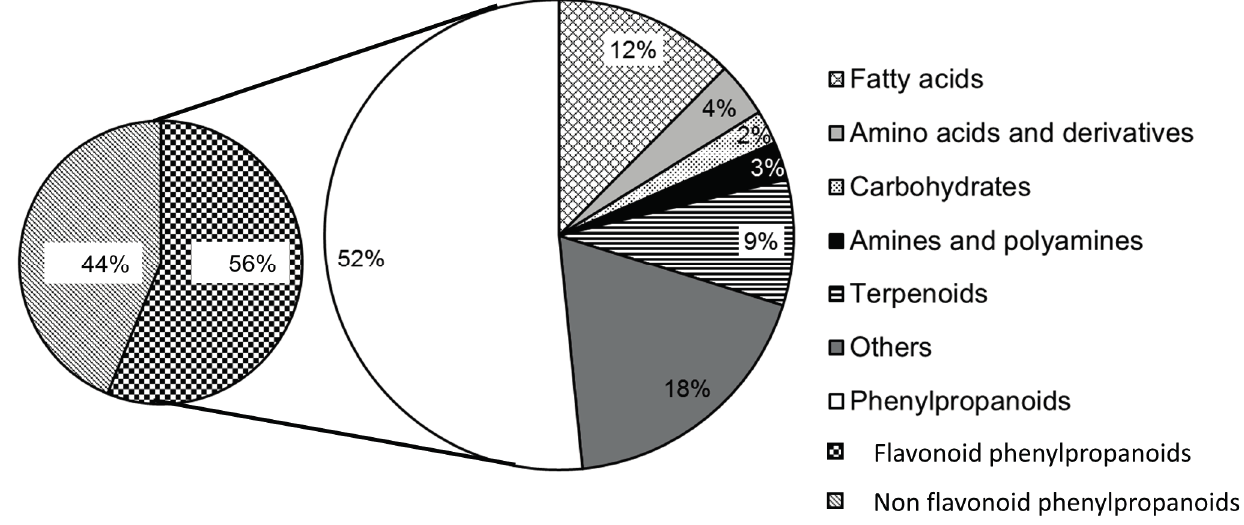
Figure 1. Chemical diversity of metabolites that have been pinpointed for their potential contribution to FHB resistance through the achievement of metabolomic studies [20–32] and have been putatively